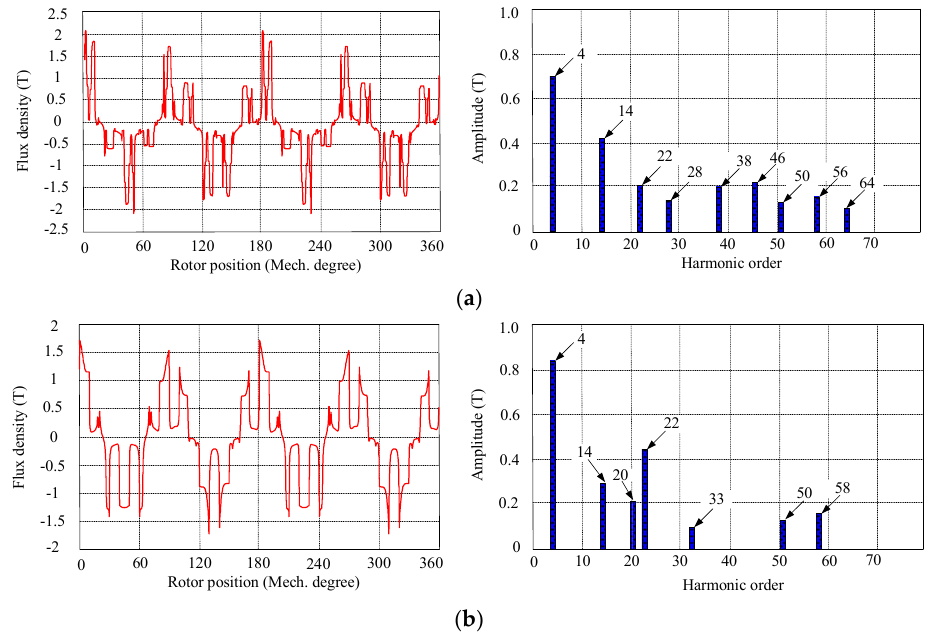
Figure 9. Distribution of air-gap flux-density and their harmonic components: ( a ) outer air-gap and ( b ) inner air-gap.